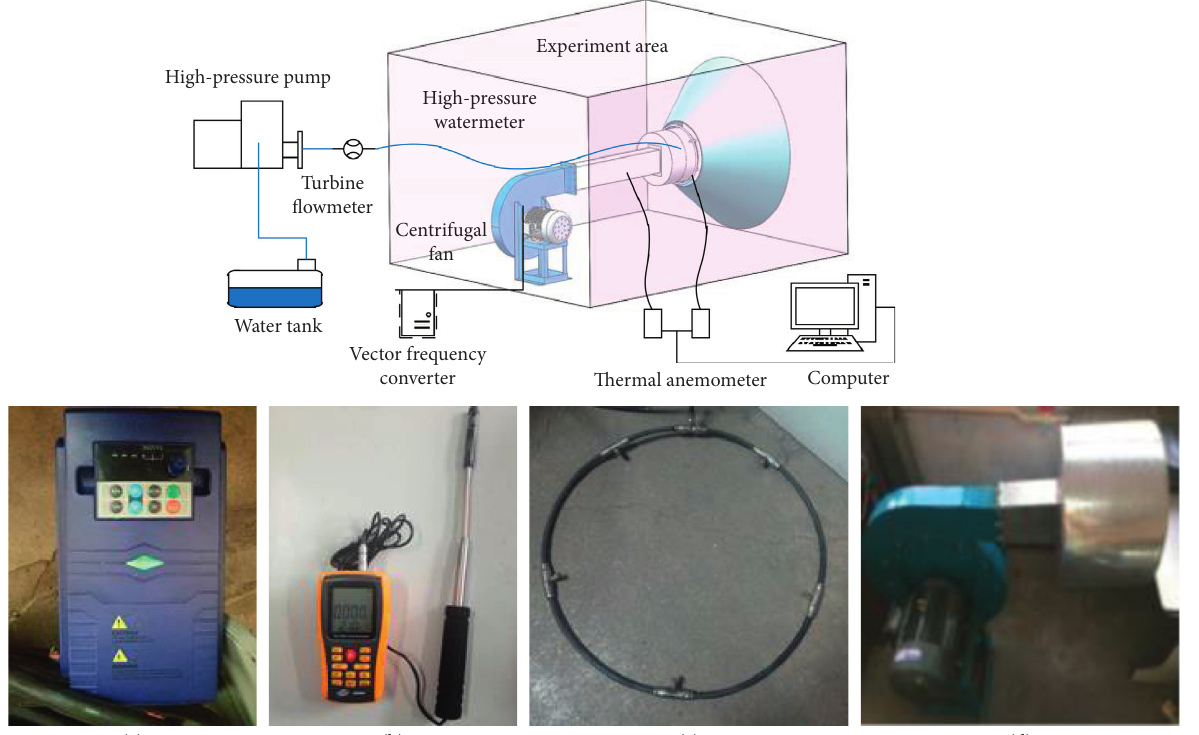
Figure 9: Schematic diagram of experimental device: (a) vector frequency converter, (b) thermal anemometer, (c) nozzles, and (d) centrifugal